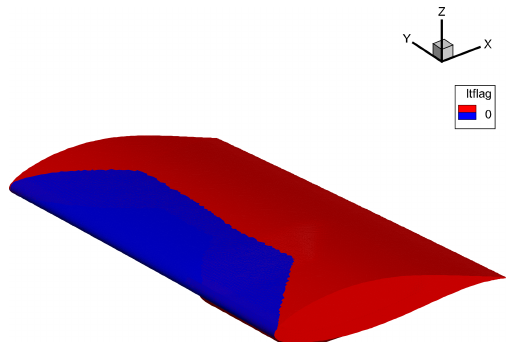
Figure 12. Estimated flow state regions from 3D transitional CFD using the DLR -TAU code. Blue: laminar flow; red: fully turbulent flow. The transition location at the mid-span of the blade is located at 30%